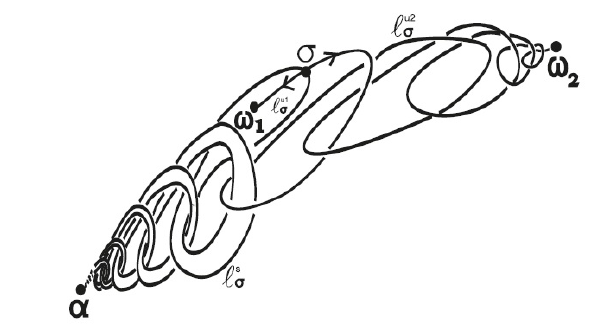
Fig. 2 The phase portrait of a non-trivial diffeomorphism of class